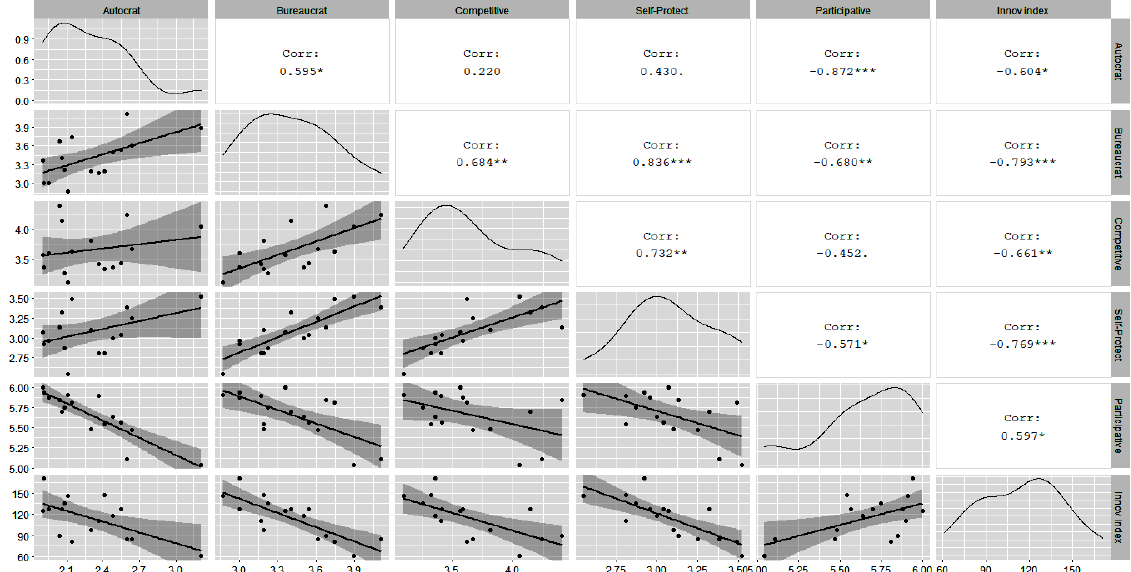
Figure 1. Visualization of correlation analysis between leadership behaviors and innovation